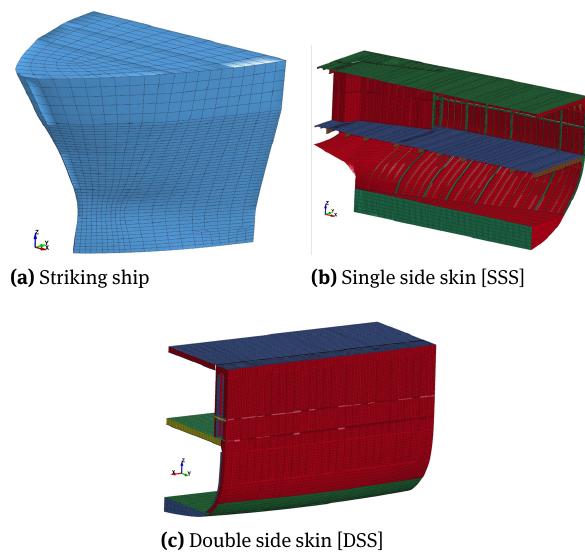
Figure 3: Idealized geometrical model for collision analysis